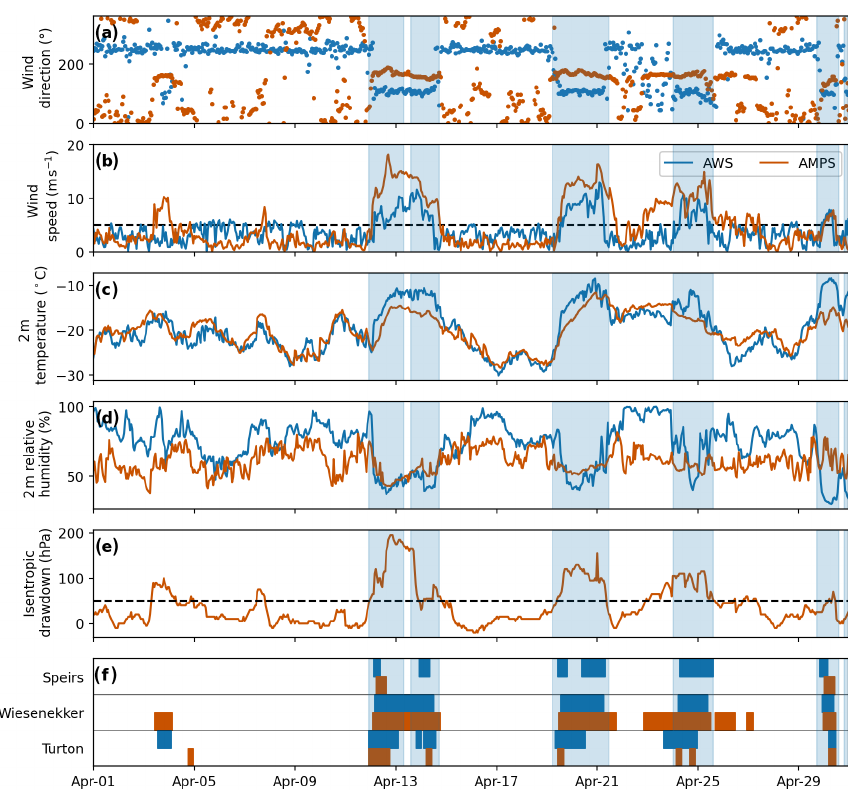
Figure 3. (a–d) Wind direction, wind speed, temperature and relative humidity based on AWS observations and AMPS forecast output at Joyce Glacier for April 2009. (e) Isentropic drawdown calculated from AMPS and (f) the periods where foehn was detected in each of the methods using near-surface conditions from AWS (blue) and AMPS (red). Blue shading indicates when foehn was flagged combining at least two different detection methods in AWS data. Note that wind speed is given at 10m for AMPS and at sensor height for AWS data.